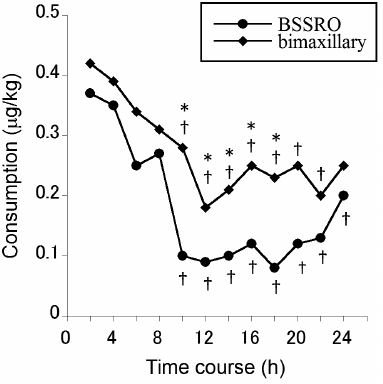
Figure 3. Differences in the time course of fentanyl adminis- tration between surgical methods. Main effects, interactions, and differences within time courses were analyzed using mixed-design ANOVA (one-way for independent groups and repeated-measures with Huynh-Feldt correction). The values indicate the medians. { P , 0.05, compared with fentanyl consumption in the first 2 h; * P , 0.05, significant difference between the BSSRO and bimaxillary groups.